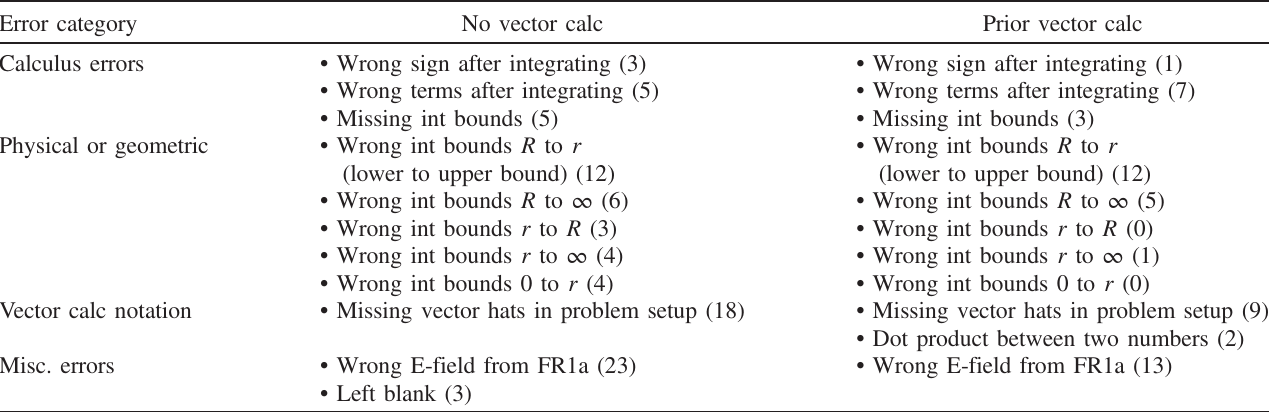
TABLE VII. Error counts from qualitative analysis of FR1c. Number in brackets is the number of students for whom we found a mistake, out of 66 total students in each category (No vector calc and prior vector calc). Error